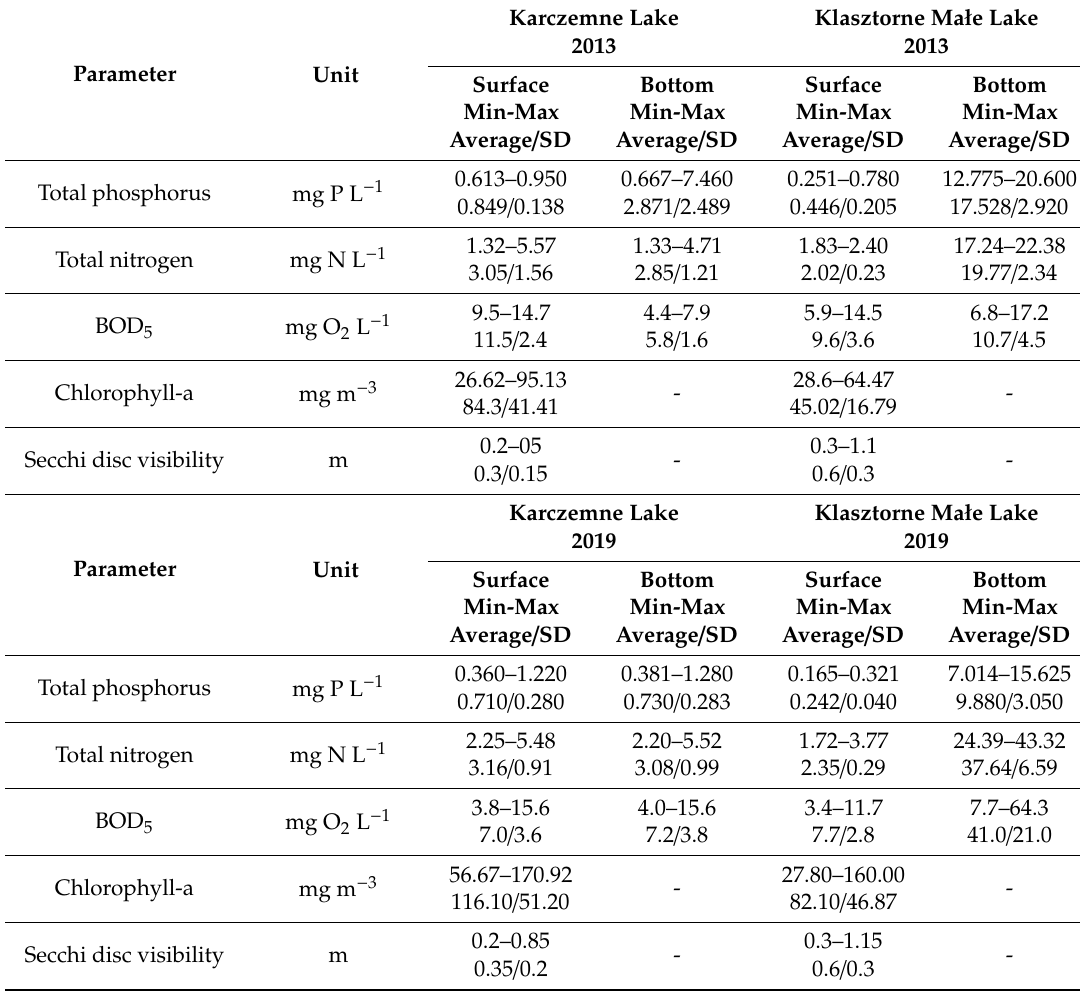
Table 3. Variability of nutrients, biological oxygen demand (BOD 5 ), chlorophyll-a, and Secchi disc visibility in study